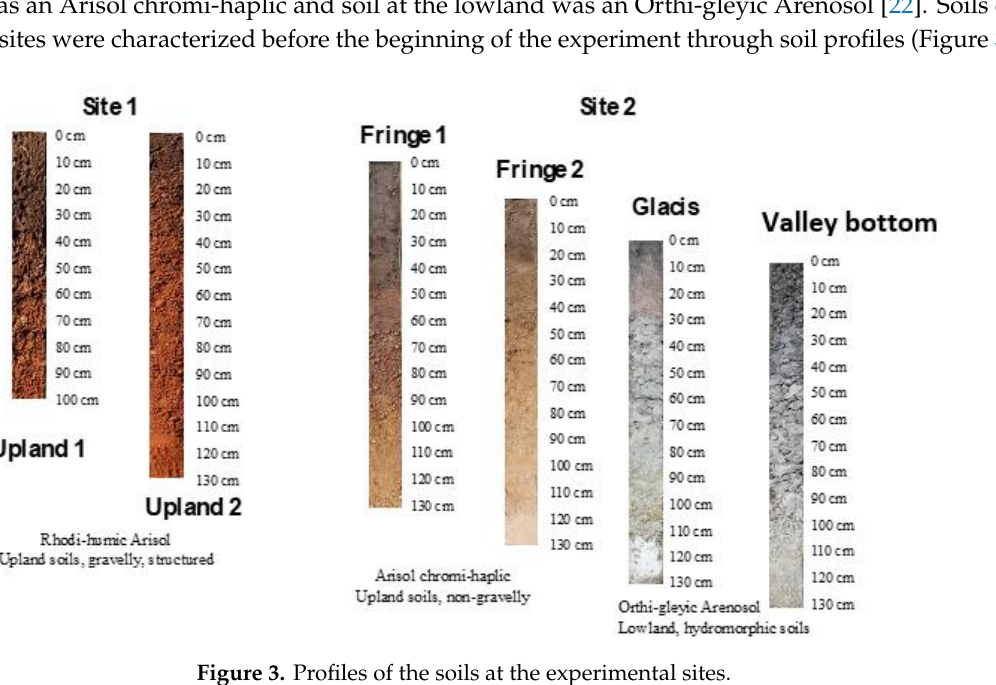
Figure 2. Sampling points and measurements.